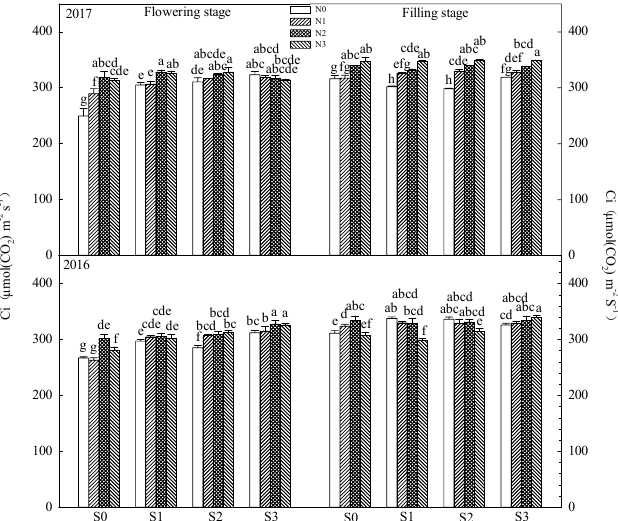
Figure 5. Effect of light and nitrogen treatment on the intercellular CO 2 concentration (Ci) of wheat. Bars indicate SD (n = 3). Values within columns followed by the same letter are statistically insignificant at the 0.05 level. Fv/Fm reflects the maximum photochemical efficiency of the PSII. The experiment showed (Figure 6) that there was no significant difference in Fv/Fm among different treat- ments, indicating that shading and nitrogen application had no effect on the maximum photochemical efficiency of PS of wheat.